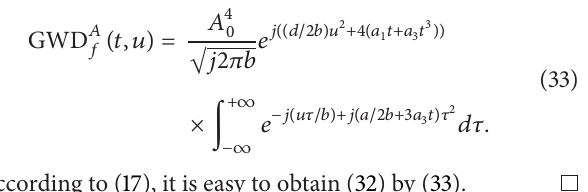
Table 1: WDLs of some common signals.